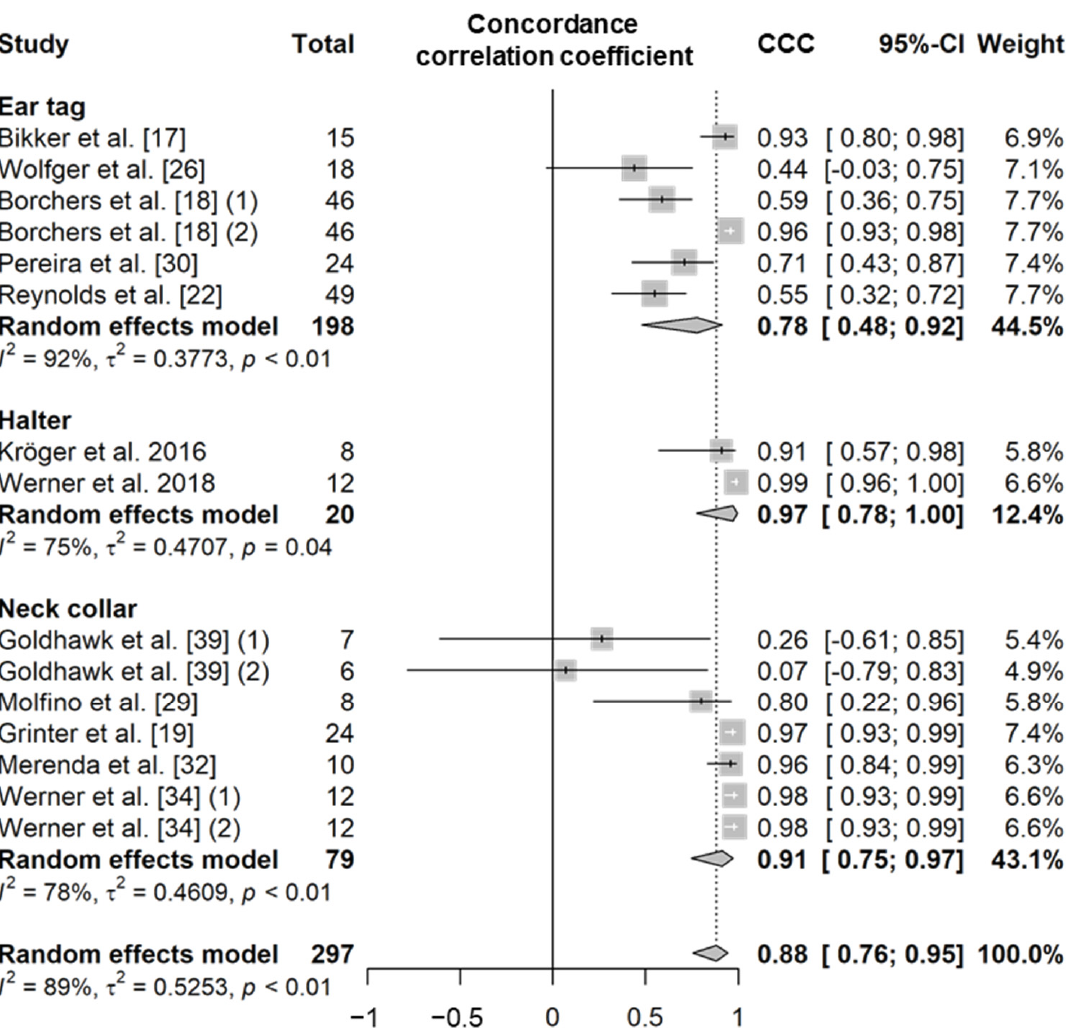
Figure 4. Forest plot of the concordance correlation coefficient of rumination time between wearable sensors and visual observation. Numbers in parentheses indicate individual studies applying different evaluation conditions within the same article. ‘Total’ means the sample size of each study and ‘Weight’ means the weight for the mean based on the sample size.